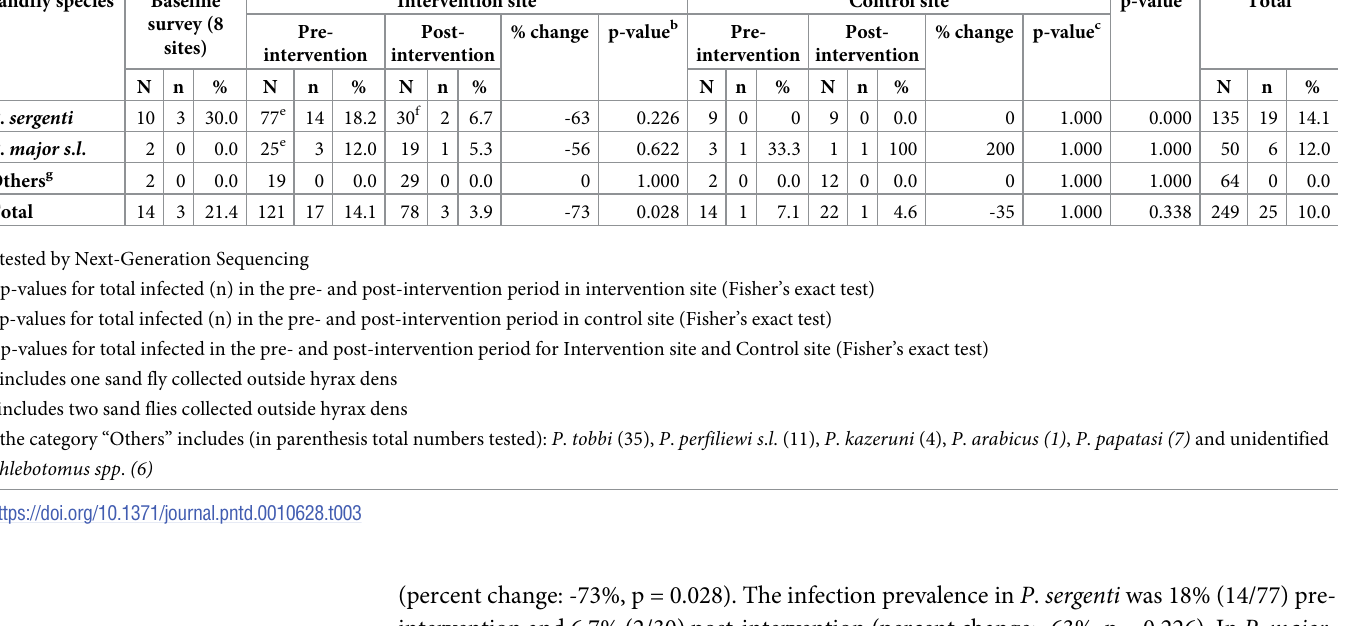
Table 3. Engorged or gravid female Phlebotomus spp . tested a (N = 249) and infected (n = 25) with Leishmania spp . during the baseline survey and in the pre- and post-intervention period in the intervention (Intervention site) and control (Control site) sites and percent change, Tayasir, Palestine, June—September 2019. Sandfly